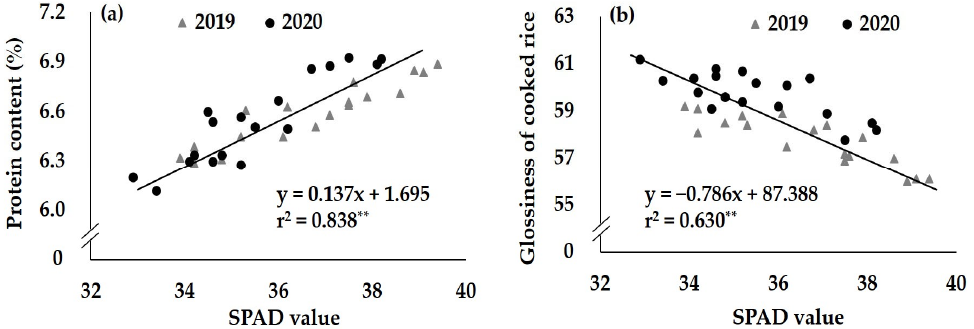
Figure 6. Relationship of SPAD value with ( a ) protein content of milled rice and ( b ) glossiness of cooked rice. **: significant at 0.01.